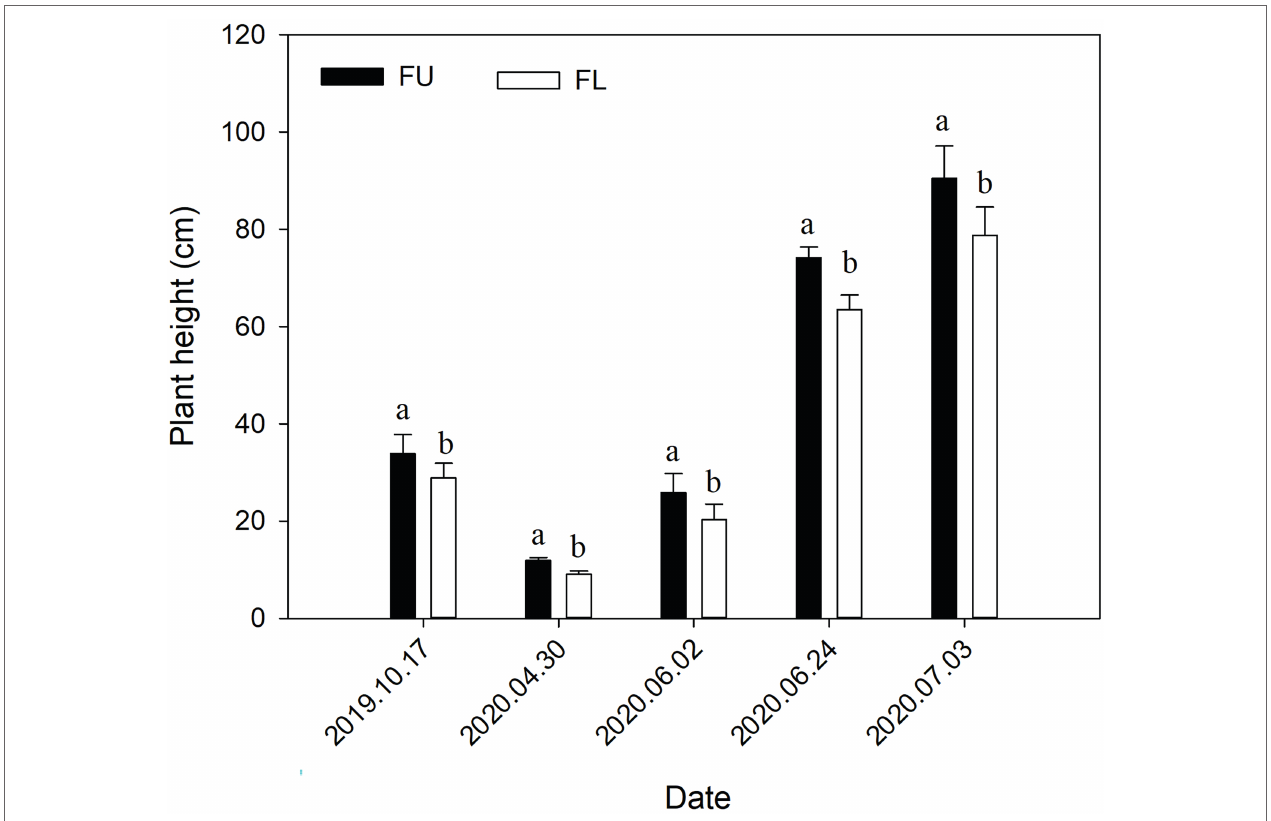
FIGURE 8 | Effects of seeding pattern on alfalfa plant height in 2019 and 2020. Values are means ( n = 4) ± SE. Different lowercase letters indicate significant difference in plant height between FU and FL at each measurement time ( p ≤ 0.05).